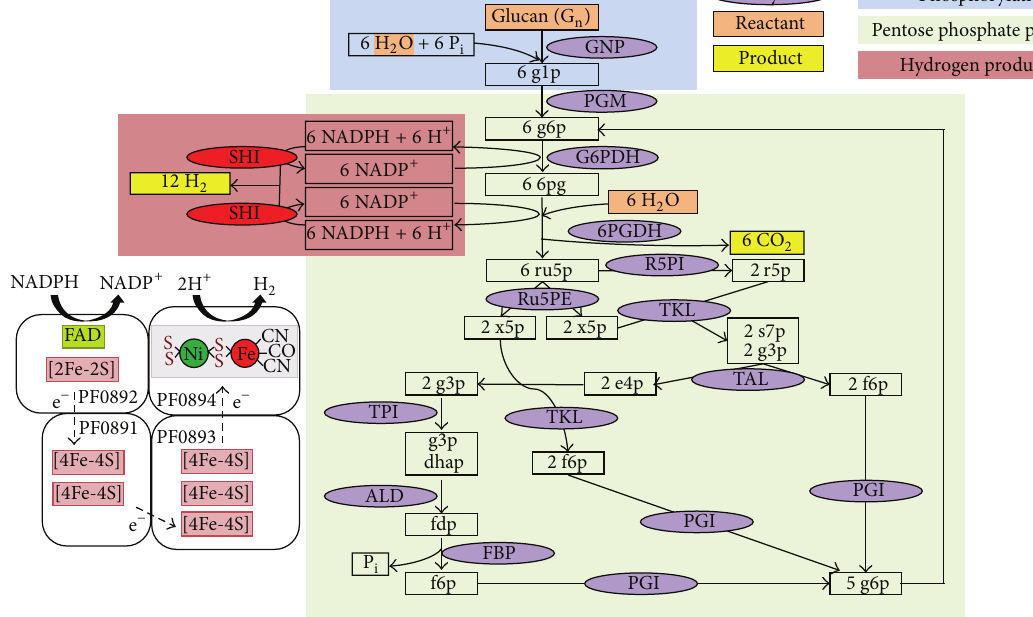
Figure 3: Biohydrogen production from glucan and water via SyPaB. SHI is colored in red and the model of tetrameric SHI (see Figure 1) shows how NADPH is oxidized to produce hydrogen. The abbreviations are GNP, glucan phosphorylase; PGM, phosphoglucomutase; G6PDH, G-6-P dehydrogenase; 6PGDH, 6-phosphogluconate dehydrogenase; R5PI, phosphoribose isomerase; Ru5PE, ribulose 5-phosphate epimerase; TKL, transketolase; TAL, transaldolase; TPI, triose phosphate isomerase; ALD, aldolase; FBP, fructose-1,6-bisphosphatase; PGI, phosphoglucose isomerase. g1p, glucose-1-phosphate; g6p, glucose-6-phosphate; 6pg, 6-phosphogluconate; ru5p, ribulose-5-phosphate; x5p, xylulose-5-phosphate; r5p, ribose-5-phosphate; s7p, sedoheptulose-7-phosphate; g3p, glyceraldehyde-3-phosphate; e4p, erythrose-4- phosphate; dhap, dihydroxyacetone phosphate; fdp, fructose-1,6-diphosphate; f6p, fructose-6-phosphate; and Pi, inorganic phosphate. Modified from